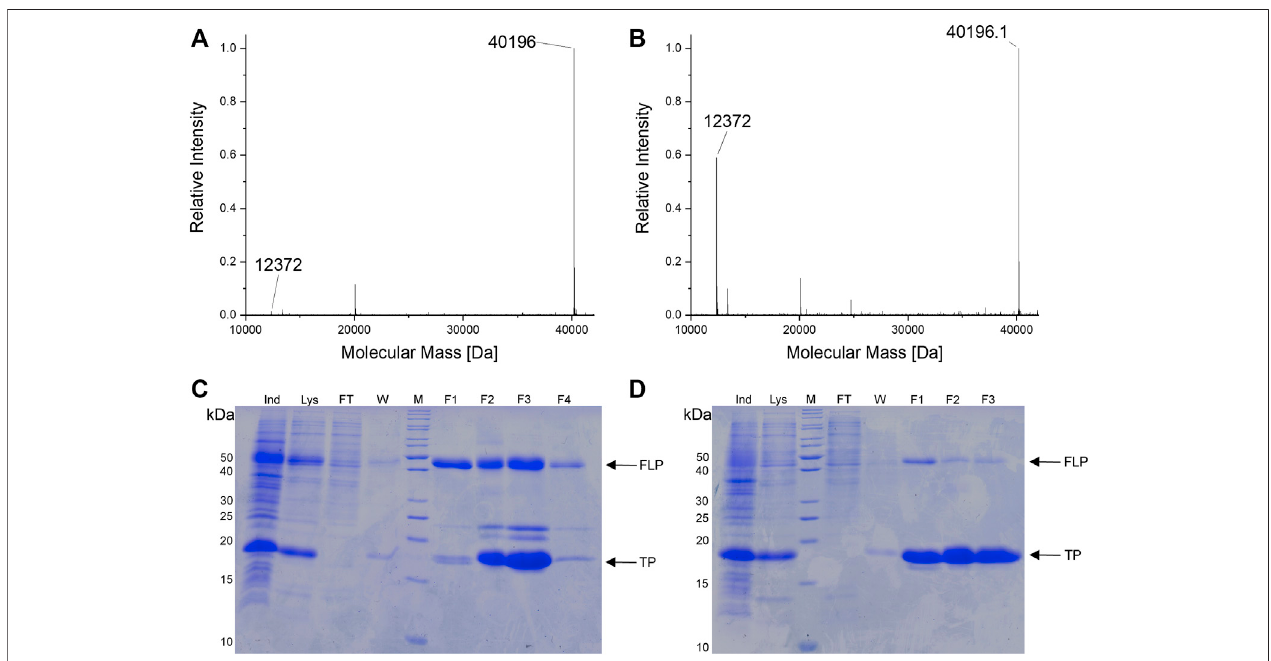
FIGURE 5 | (A,B) Deconvoluted ESI-MS spectra of SUMO-sfGFP(R2Sac) produced in E. coli BL21 (DE3). (A) Reporter co-expression with SmbP- Mb SacRS. Expected protein mass of SUMO-sfGFP(R2Sac): 40,194.9 Da. Observed mass: 40,196 Da. (B) Co-expression with untagged Mb SacRS. Expected mass of SUMO sfGFP(R2Sac): 40,194.9 Da. Observed mass: 40,196.1 Da. Expected mass of SUMO truncation product: 12,372.8 Da. Observed mass: 12,372 Da (A and B). (C,D) SDS-PAGE analysis of puri fi ed SUMO-sfGFP(R2Sac) protein produced via co-expression of (C) SmbP- Mb SacRS and (D) unmodi fi ed Mb SacRS. Sample abbreviations:Wholecellextractofinducedculture (Ind),solublecellularlysate (Lys),liquid chromatography fl ow-through(FT),columnwashofboundprotein (W),eluate fractions (F1-3/4), protein ladder (M), full-length product (FLP), truncation product (TP).